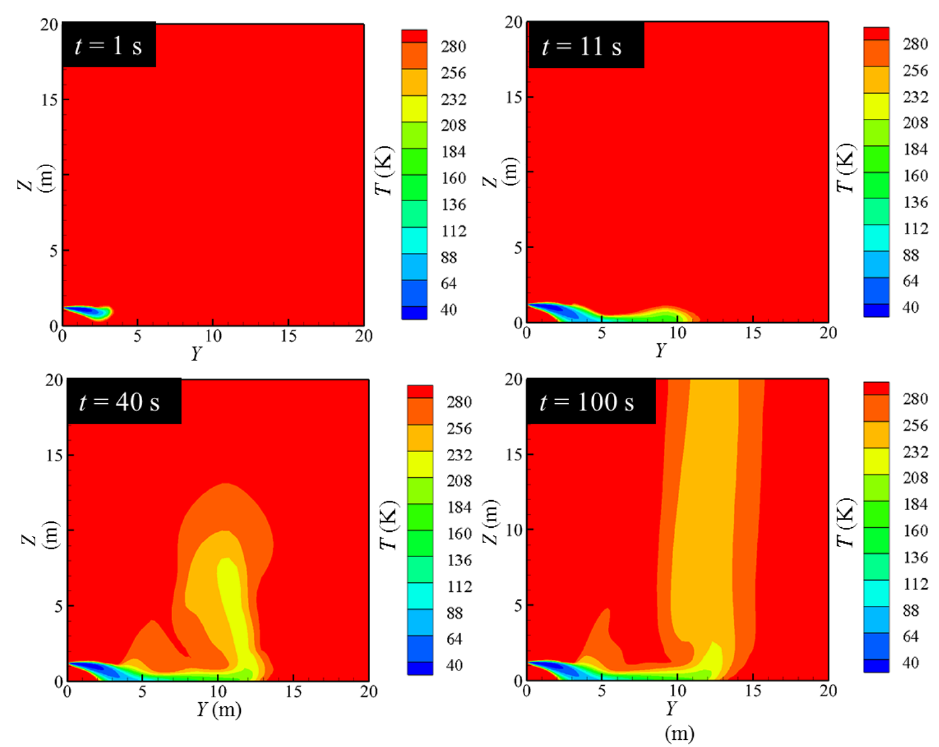
Figure 6. Variation of hydrogen concentration distribution.